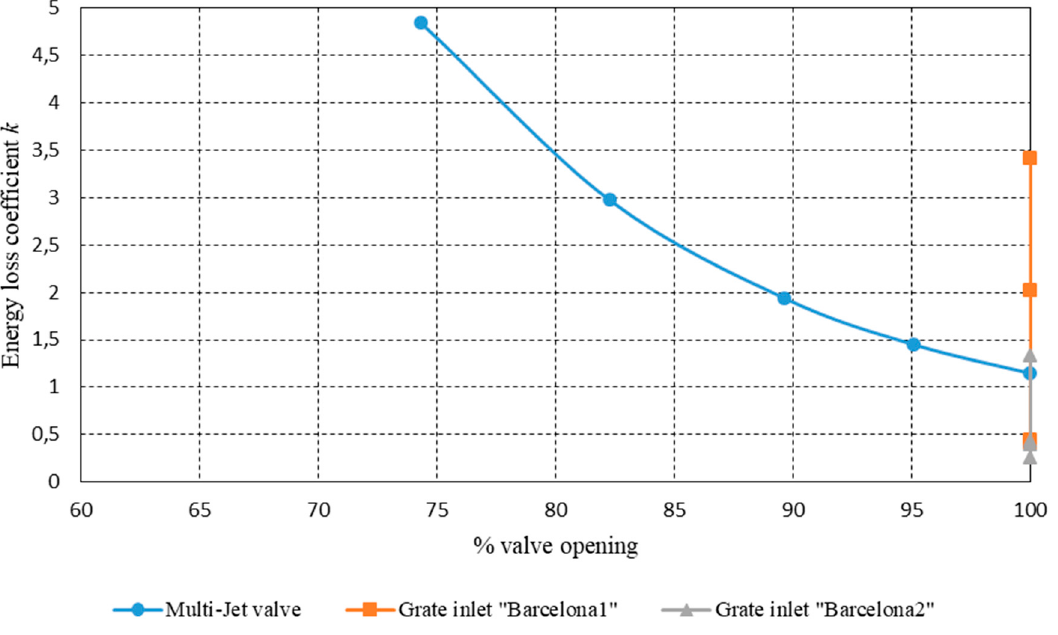
Figure 10. Energy loss coefficient vs. % valve opening for a multi-jet valve [44].